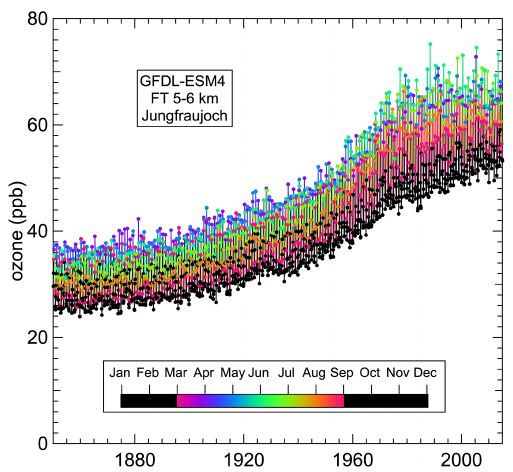
Figure 1. Example time series of 165 years of monthly mean ozone concentrations simulated by the GFDL-ESM4 model in the FT be- tween 5 and 6km above Jungfraujoch. Ozone concentrations are colored according to the month of the year to illustrate the phase shift in the seasonal